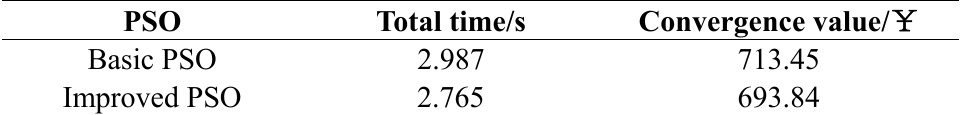
Table 5. Comparison of computational results between basic and improved PSO.